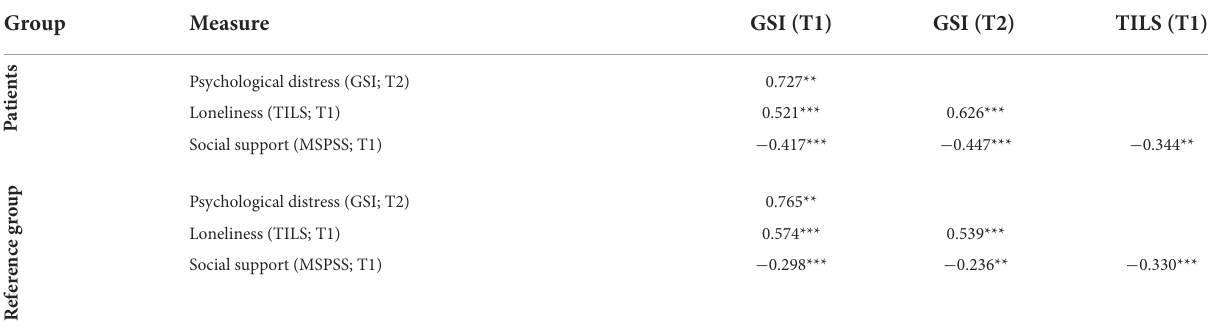
TABLE 3 Correlations between T1 and T2 variables (Spearman’s rho).